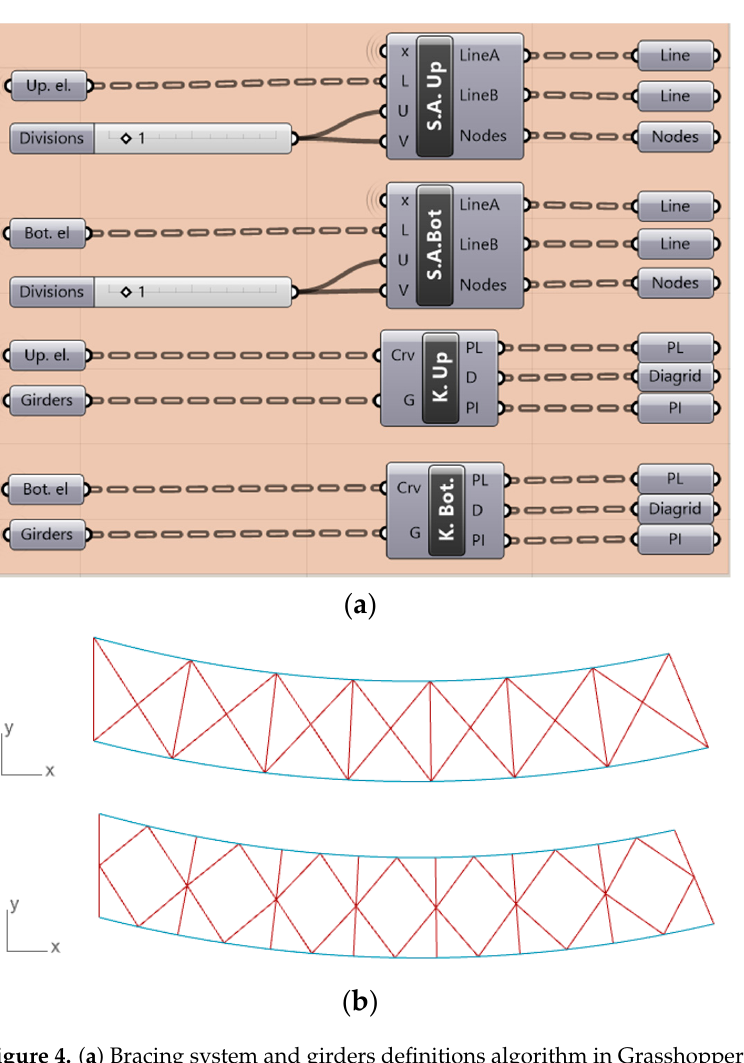
Figure 4. ( a ) Bracing system and girders definitions algorithm in Grasshopper environment; ( b ) bracing systems visualization.